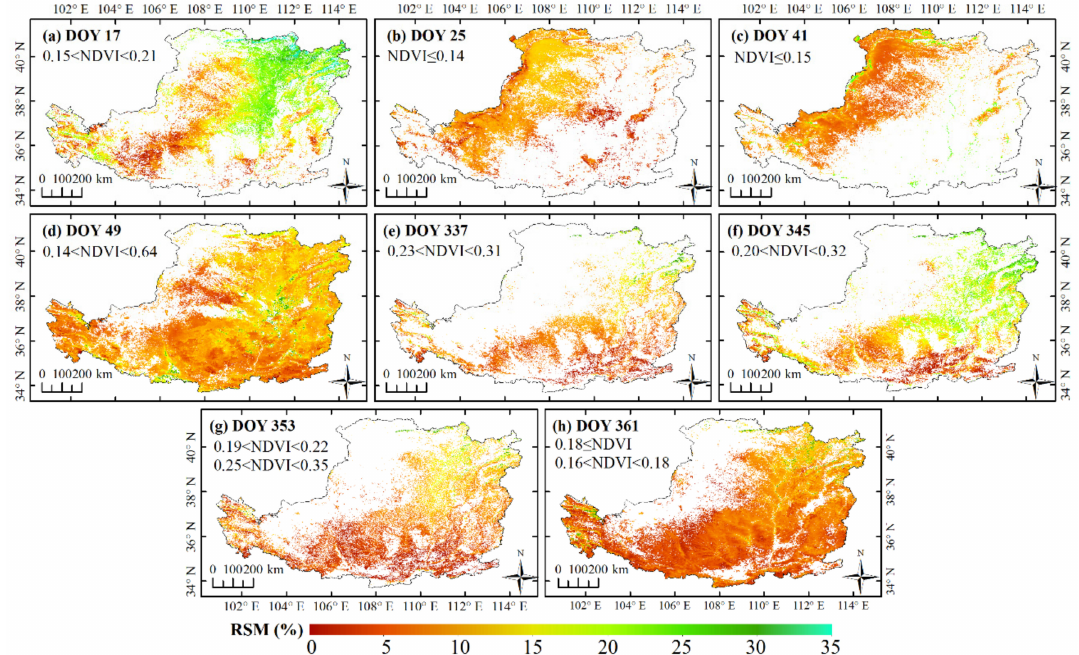
Figure 10. Spatiotemporal patterns of the relative soil moisture in the winter of 2017. ( a ) DOY 17 for 0.15 < NDVI < 0.21 using the ATI / TVDI joint model, ( b ) DOY 25 for NDVI ≤ 0.14 using the ATI-based model, ( c ) DOY 41 for NDVI ≤ 0.15 using the ATI-based model, ( d ) DOY 49 for 0.14 < NDVI < 0.64 using the ATI / TVDI joint model, ( e ) DOY 337 for 0.23 < NDVI < 0.31 using the ATI / TVDI joint model, ( f ) DOY 345 for 0.20 < NDVI < 0.32 using the ATI / TVDI joint model, ( g ) DOY 353 for 0.19 < NDVI < 0.22 and 0.25 < NDVI < 0.35 using the ATI / TVDI joint model, ( h ) DOY 361 for 0.18 ≤ NDVI and 0.16 < NDVI < 0.18 using the TVDI-based model as well as the ATI / TVDI joint model,